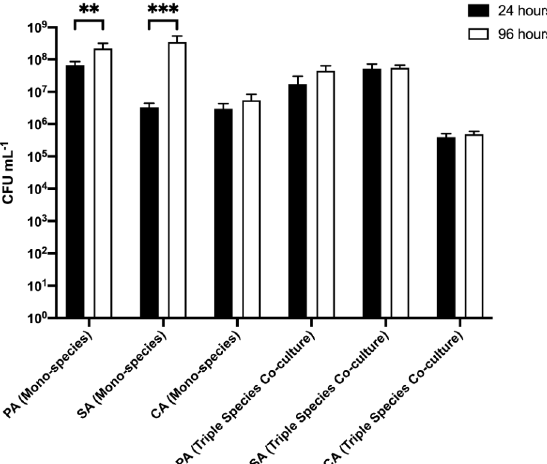
Figure 5. Cell titres derived from biofilms adhered to agar chunks. P. aeruginosa PAO1 (PA), S. aureus 25923 (SA) and C. albicans SC5314 (CA) cell counts (expressed as CFU mL -1 ) adhered to 2.5% (w/v) agar chunks after incubation for 24 h (black bars) or 96 h (white bars) in the continuous-flow culture model. Asterisks indicate significant (** P < 0.01, *** P < 0.001) differences in CFU mL -1 counts between the 24 h and 96 h time points. Data represent